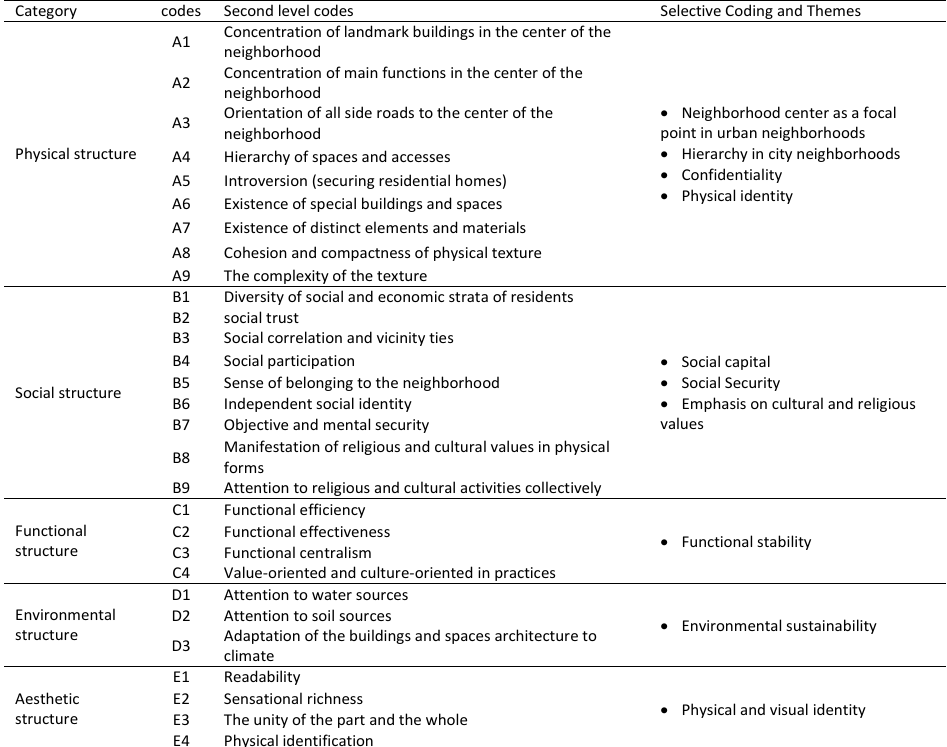
Table 3: Selective Coding in the neighborhood design principles of desert areas Category